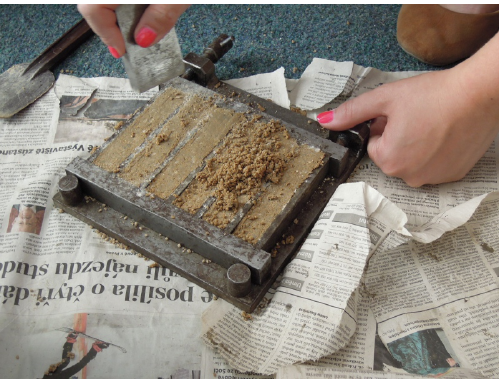
Figure 9. The pressing down to the